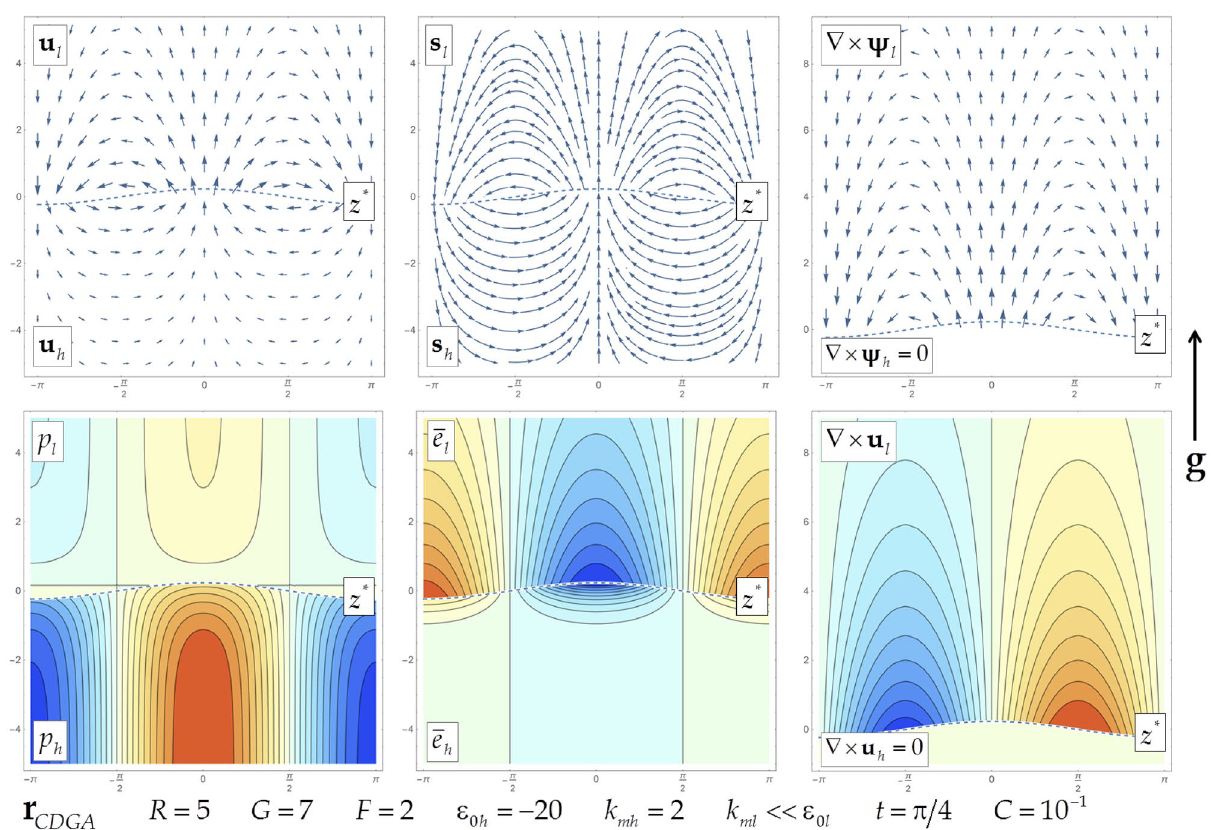
Fig. 2 Flow fields for unstable accelerated advection: plots of real parts of perturbed fields of the interface, velocity, velocity streamlines, pressure, vorticity, internal energy, with red (blue) for positive (negative) in contour plots